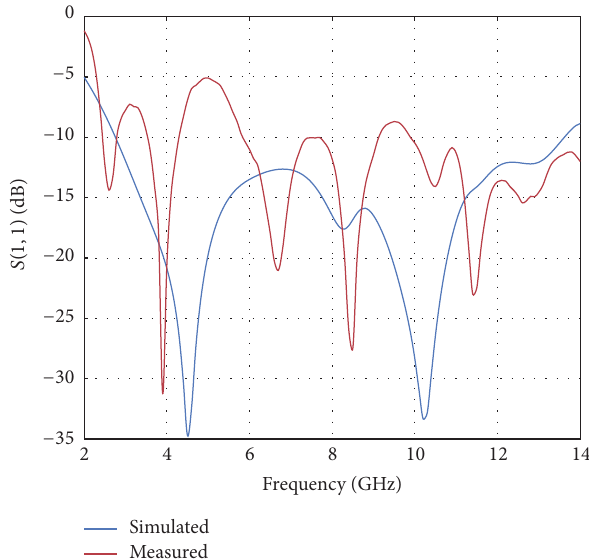
Figure 20: Comparison of simulated and measured reflection coefficients of the UWB